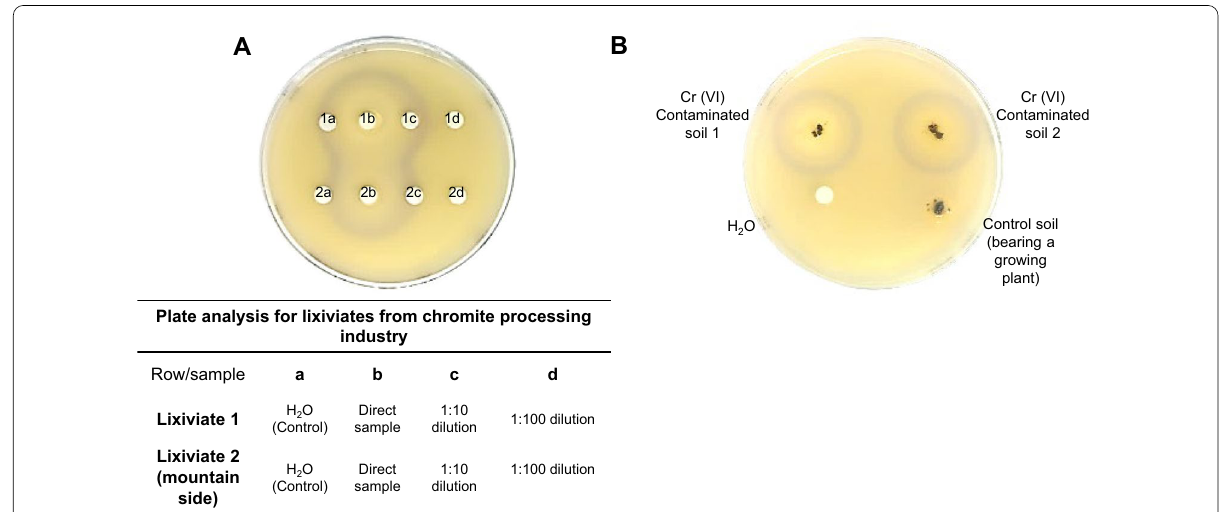
Fig. 5 Reporter strain activation with samples from polluted soil from a chromite processing facility. In A the reporter strain activation was assessed with different concentrations of the leachate soil. The table indicates the concentration applied to the plate. In B the reporter strain was exposed to samples of soil directly placed on top of the soft agar‑cell mat surface and fixed with soft LB‑agar. As a control, soil from a growing plant was used. The clear area on each experiment indicates cell death. The purple halos indicate reporter strain